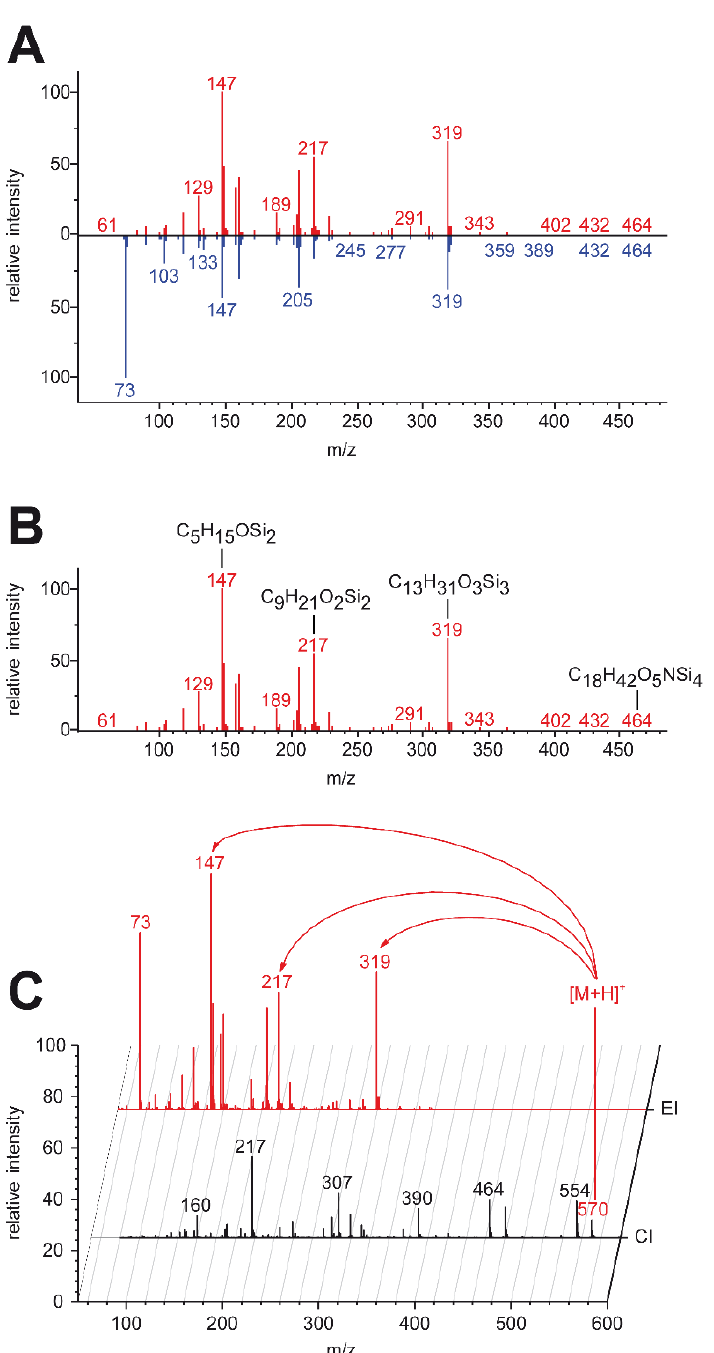
Figure 6. Metabolite identification workflow using high-resolution GC–MS. ( A ) EI database matching. Unit-mass EI spectra from commercially and freely available databases (blue) are compared with the unknown spectrum (red). ( B ) Calculation of sum formulas of several fragments using accurate mass capabilities. If sum formulas fit to the proposed compound by database matching, it is treated as putatively annotated, pending identification by measuring an analytical standard. ( C ) For unknown compounds with poor database matches, an accurate mass molecular ion from CI measurements (black) is assigned to the EI spectrum of the unknown (red). In silico fragmentation of candidate structures is performed and results are compared with recorded EI data [32].